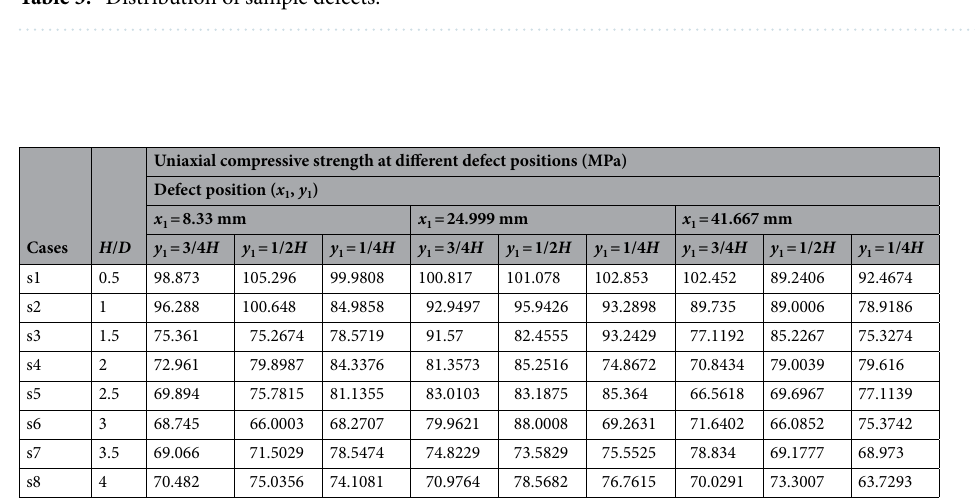
Table 4. Uniaxial compressive strength of defective rock